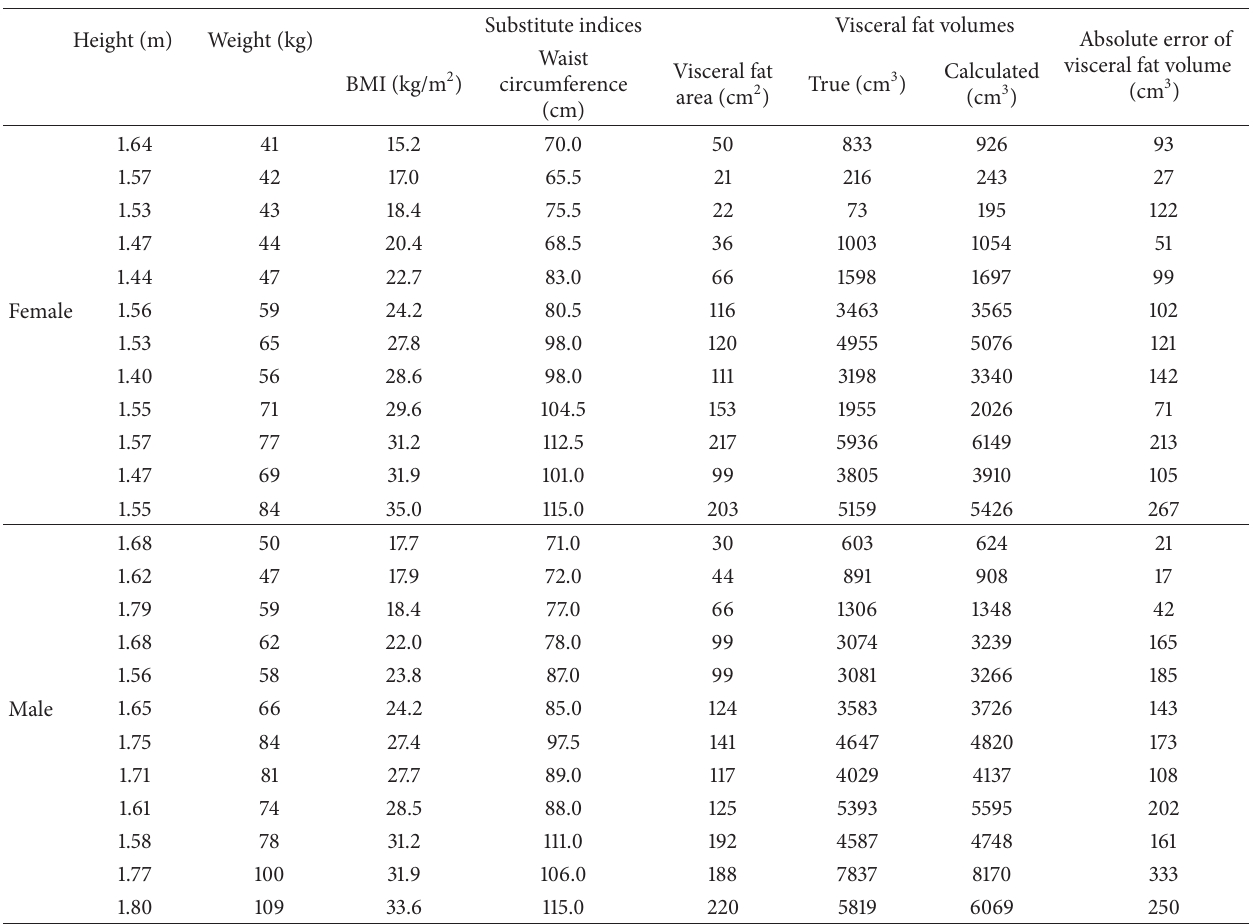
Table 1: List of data sets with substitute indices for visceral fat volume, calculated true visceral fat volume, and automatically calculated visceral fat